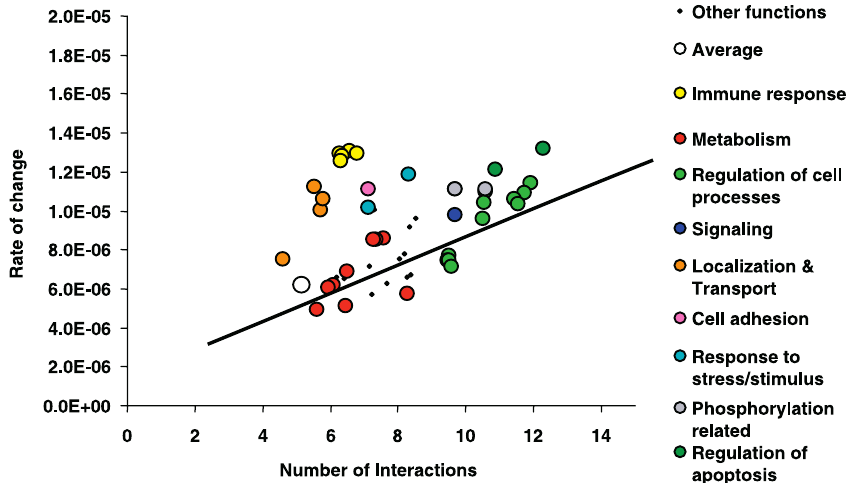
Figure 3. Biological Process Can Determine Link Dynamics Independently of the Number of Interaction Partners We have binned proteins according to the biological processes, defined in Gene Ontology, and calculated for each bin the average number of interactions and average rate of change of interactions (see Materials and Methods). The black line represents the expected rate of change for proteins with increasing numbers of interactions. doi:10.1371/journal.pcbi.0030025.g003 PLoS Computational Biology |